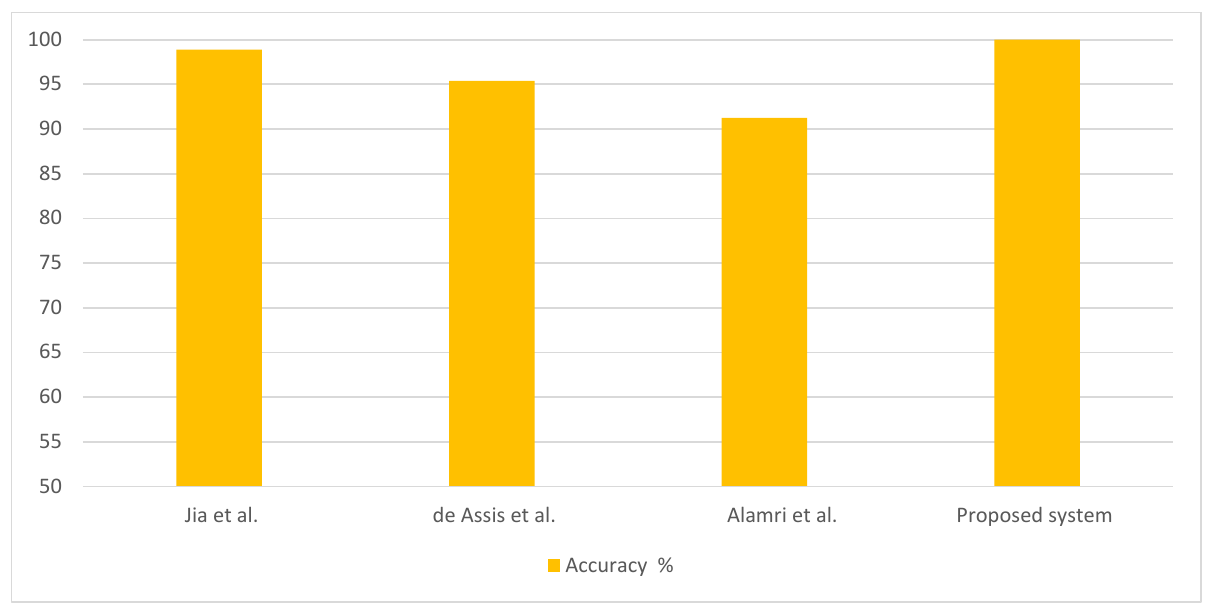
Figure 12. Comparative performance between the CNN–LSTM model and existing approaches to the detection of Agriculture 4.0 attacks.